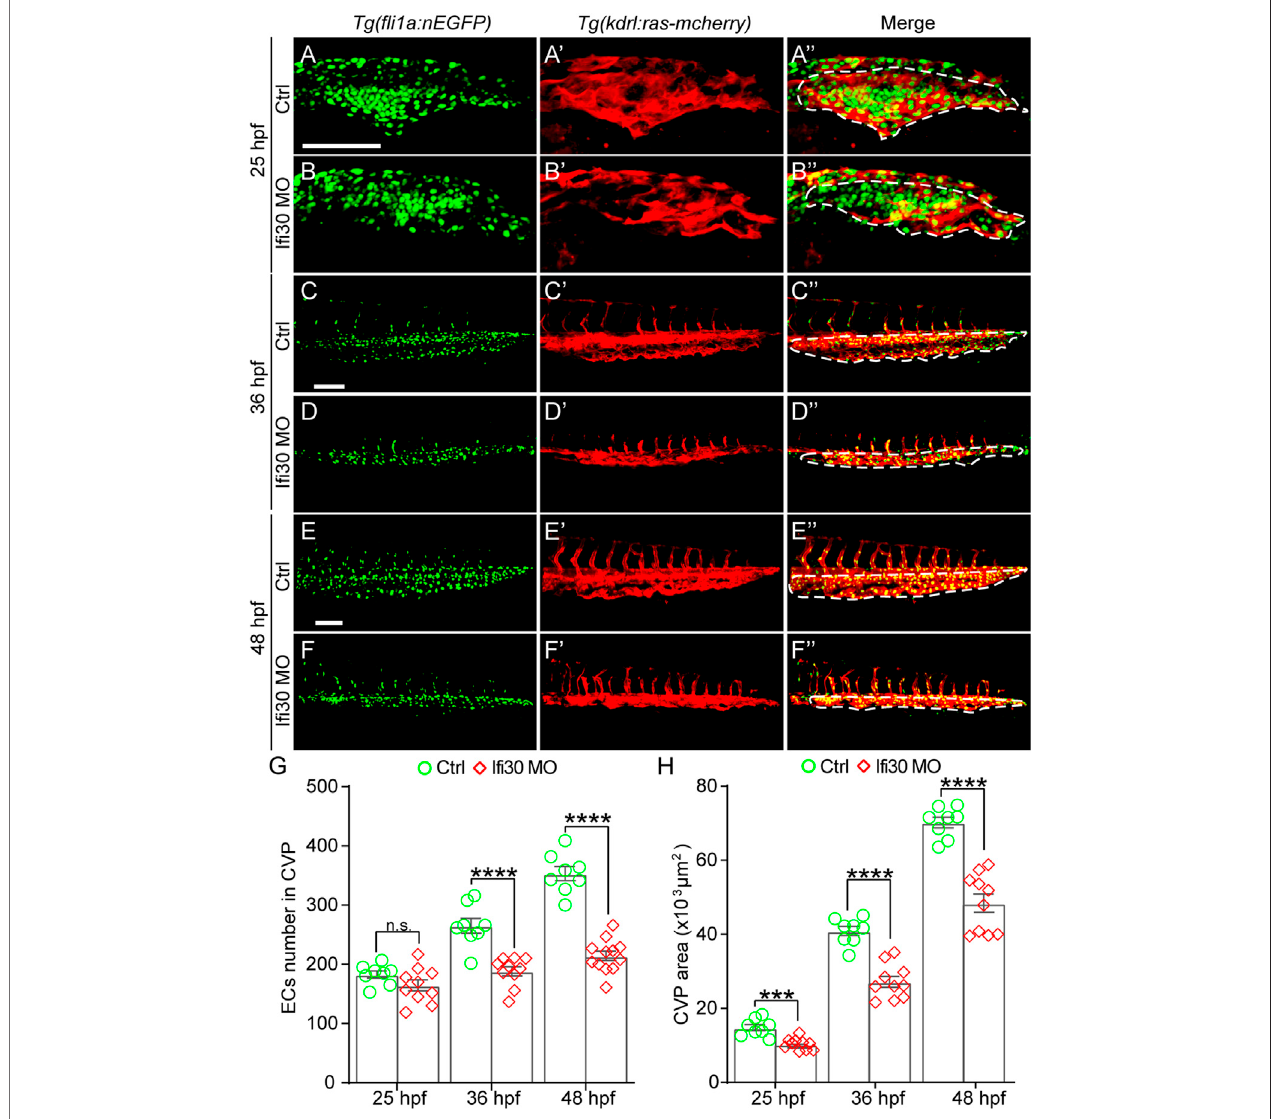
FIGURE4| I fi 30loss-of-functionimpairsendothelialcell(EC)proliferationduringCVPdevelopment (A – F") Confocalimagesof Tg(kdrl:ras-mCherry);Tg( fl i1:nEGFP) double transgenic embryos and embryos injected with I fi 30 MO at 25 hpf (A,B") , 36 hpf (C,D") , and 48 hpf (E,F") . The EC numbers in the CVP region and CVP area (white dotted line outlined area) were quanti fi ed (G,H) . Error bars represent SEM. n. s., not signi fi cant. ***, p < 0.001. ****, p < 0.0001. Scale bars, 100 µm.